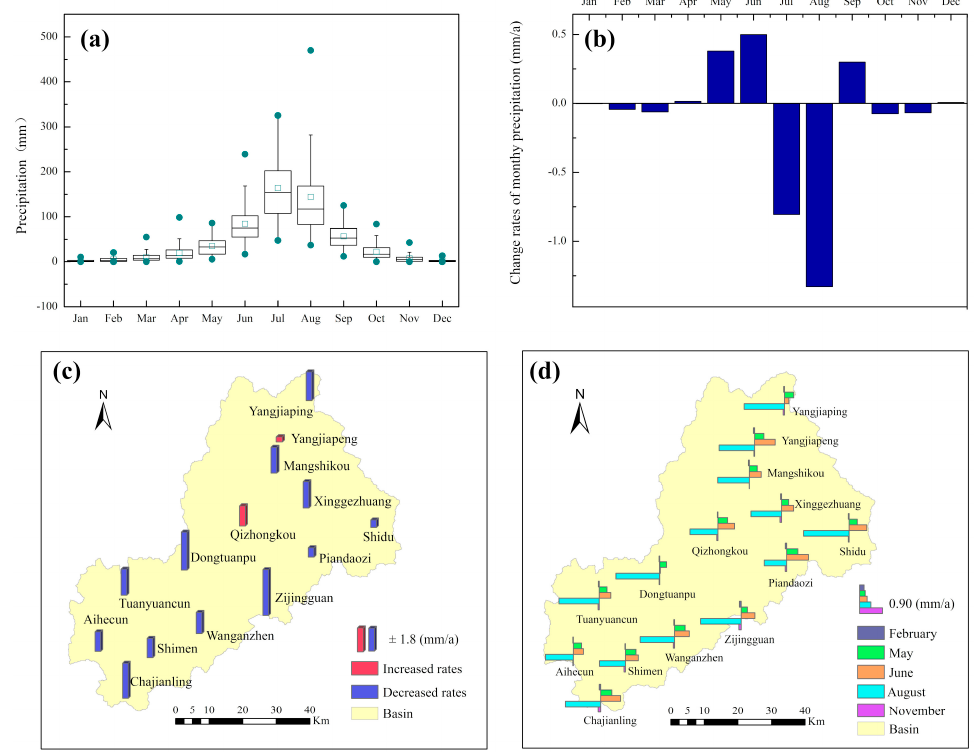
Figure 12. Distribution of precipitation during the year ( a ) and the variation rate of precipitation ( b – d ).